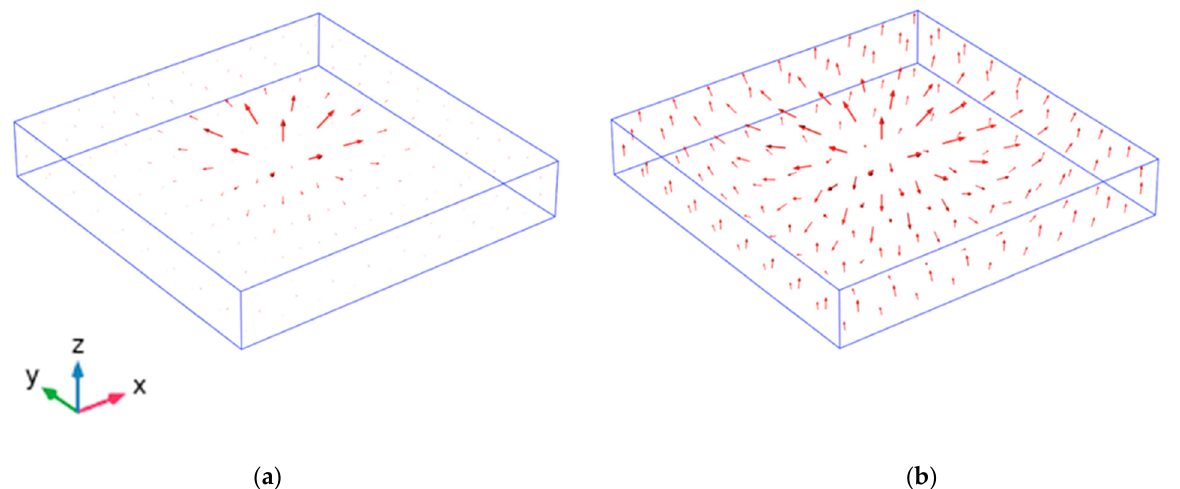
Figure 4. Overview of the profile of the light-induced electric field distribution inside the liquid crystal layer in the optofluidic channel. ( a ) Length of the arrows proportional to the field strength; ( b ) same as ( a ) in logarithmic scale, made in order to make the spatial evolution of the electric field direction inside the liquid crystal layer more visible.